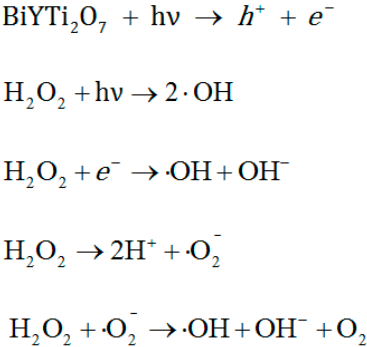
Scheme 1. Mechanism of photocatalytic activity with H 2 O 2 in the AG.